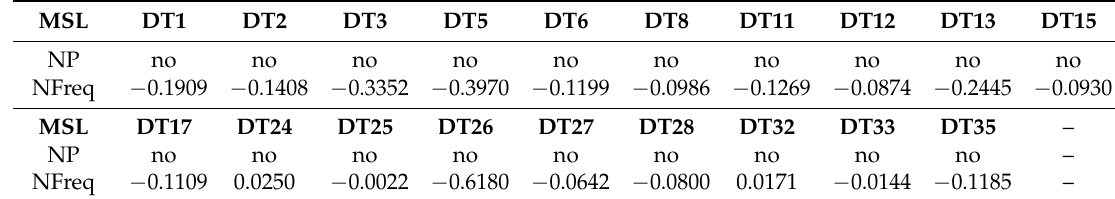
Table 3. Statistical summary of the results from PCR errors and the null allele test in the Korean population of Dorcus titanus castanicolor .